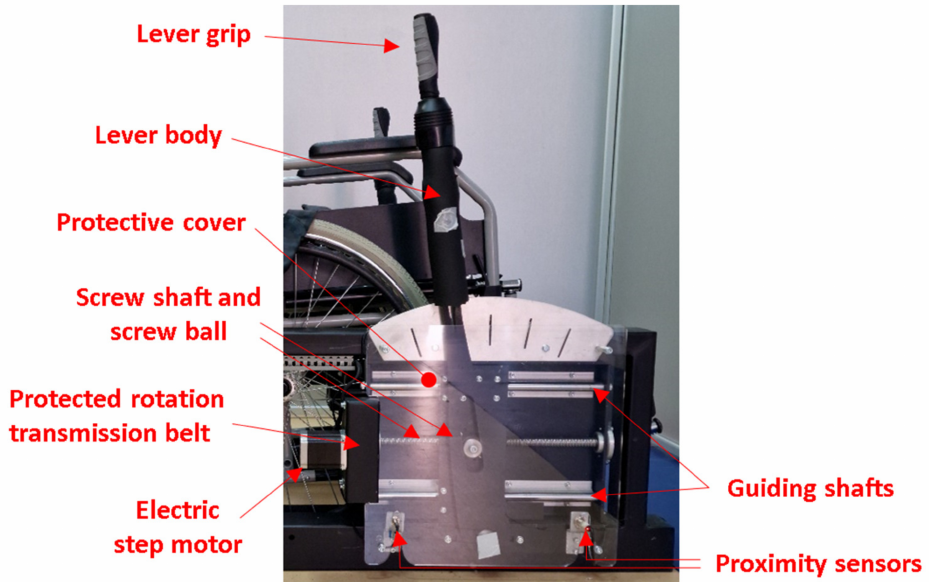
Figure 6. Basic parts of the otorized lever systems.